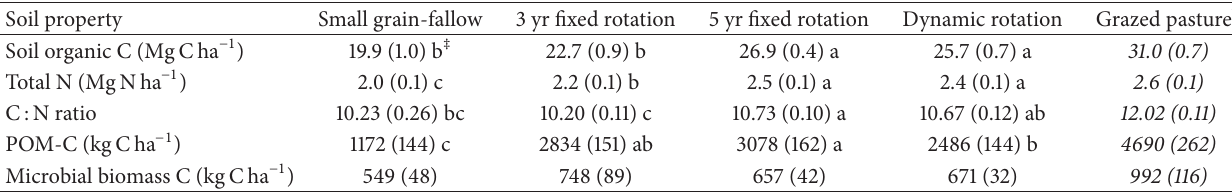
Table 3: Crop diversity effects on soil carbon, nitrogen, C:N ratio, particulate organic matter (POM) C, and microbial biomass C at 0–10 cm for long-term crop and pasture treatments near Mandan,